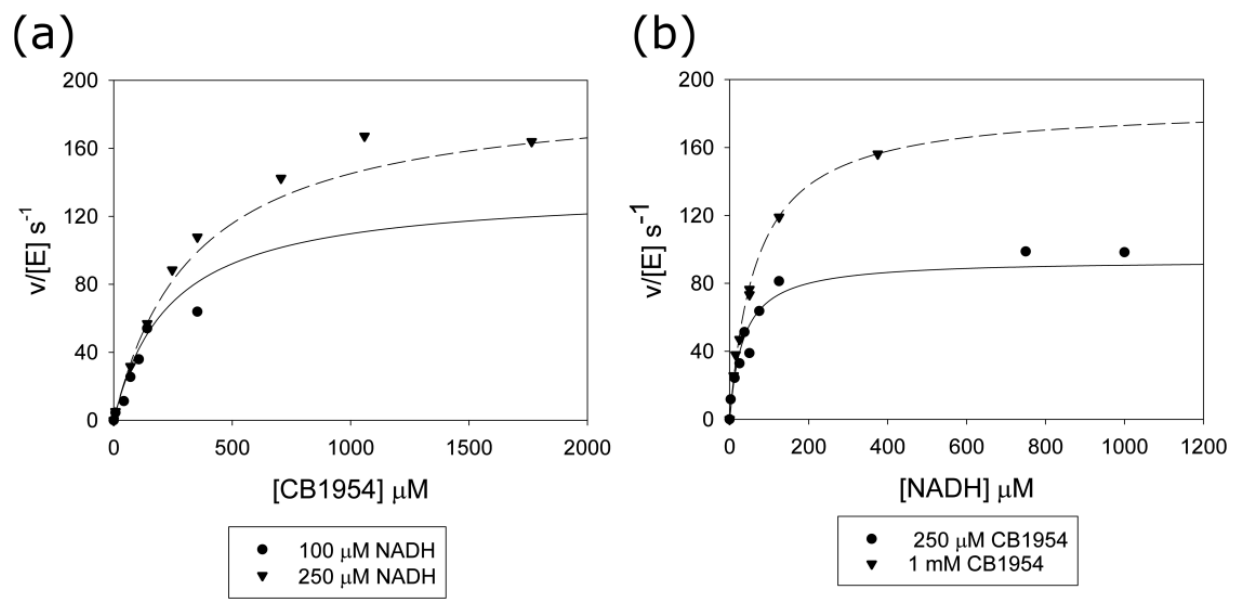
Figure 6. Steady-state rates of the reduction of CB1954 with NADH catalysed by T41Q/N71S/F124T/M127V NfsB. The reactions were done in 10 mM Tris HCl pH 7.0 buffer contain- ing 1.1% NMP and 3.9% PEG 300 at 25 °C and monitored at 420 nm. ( a ) Reactions at constant NADH concentrations, varying CB1954 concentrations. Circles—initial rates of reaction at 100 µ M NADH; triangles—250 µ M NADH. ( b ) Reactions at constant CB1954 concentrations, varying the NADH concentrations. Circles—initial rates of reaction at 250 µ M CB1954, triangles—1 mM CB1954. The lines show the fit of the data to Equation (4), with k cat 270 s − 1 , K m CB1954 460 µ M, and K m NADH 100 µ M. The dashed lines are the calculated rates for the higher concentration of varied substrate, with the solid lines showing the calculated rates for the lower concentrations of varied substrate. All the structures remained stable over the dynamics runs. The root-mean-square deviations (RMSDs) of the C α atoms in the entire structures show an initial rise for about 20 ns and then a stable difference of 1.3 ± 0.1 Å from the initial structures. Figure 8 shows the root-mean-square fluctuations (RMSFs) of the individual C α atoms averaged over the three runs in each site. In all cases, C α atoms from residues 65–70, 108–134, and 196–204 show higher RMSFs than others, with residues 65–67, 109–112, and 131–133 showing fluctuations greater than 1.5 Å and maximum RMSFs at residues 66, 109, and 131–132. A standard deviations between the runs. There are no significant differences between